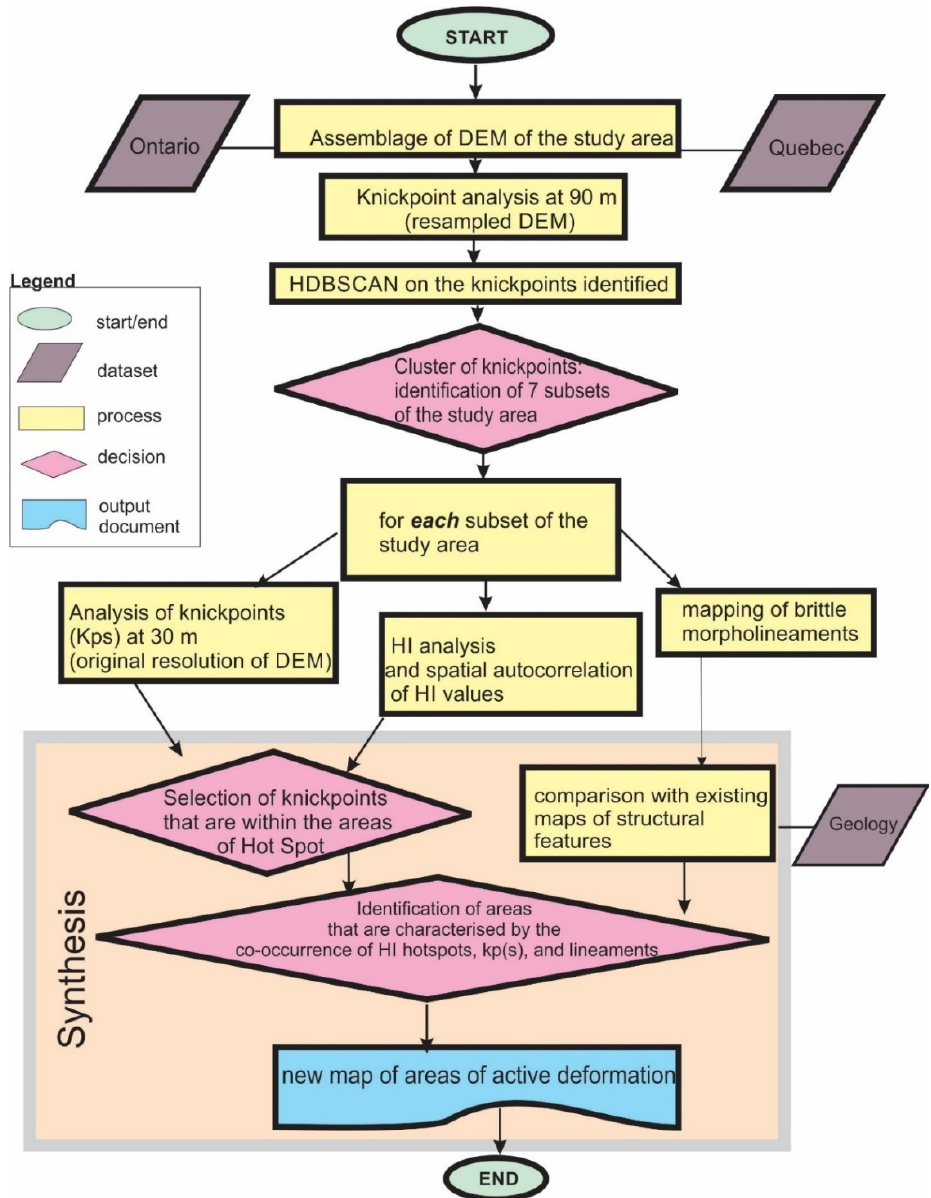
Figure 3. Workflow diagram for the methodology proposed in this study. We integrate multiple techniques commonly used in tectono-geomorphic studies that involve complex digital topogra- phy and hydrological